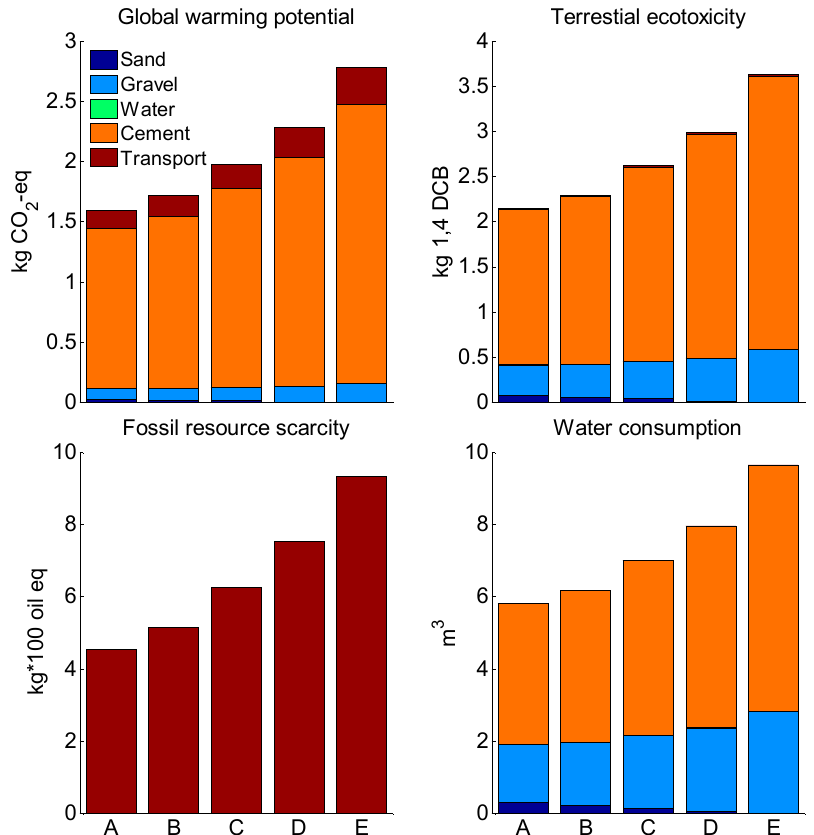
Figure 5. Replacing sand with coal bottom ash (CBA): A—CBA0, B—CBA25, C—CBA50, D—CBA75, and E—CBA100. The environmental impacts were evaluated following the ReCiPe2016 midpoint